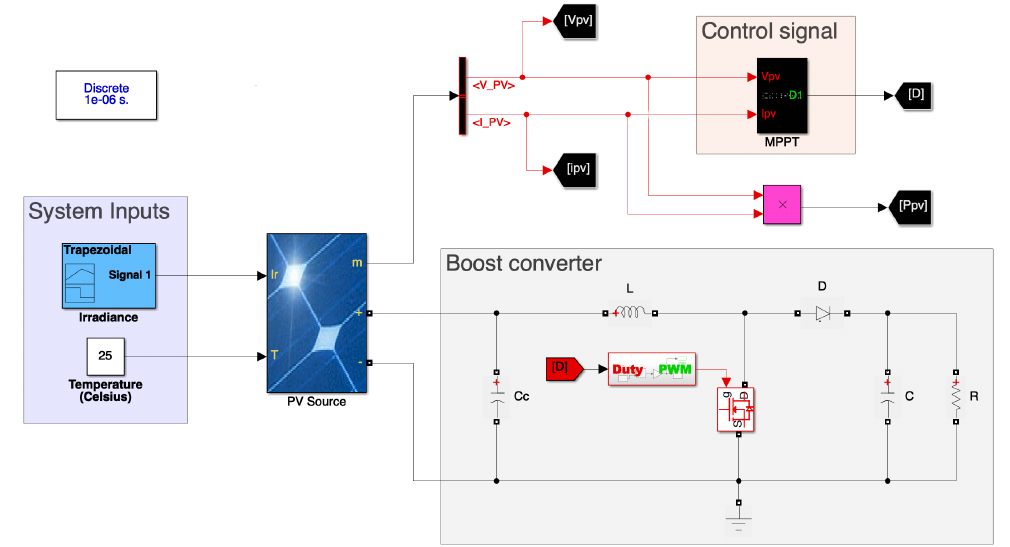
Figure 15. Blocks diagram for the Simulink simulations.